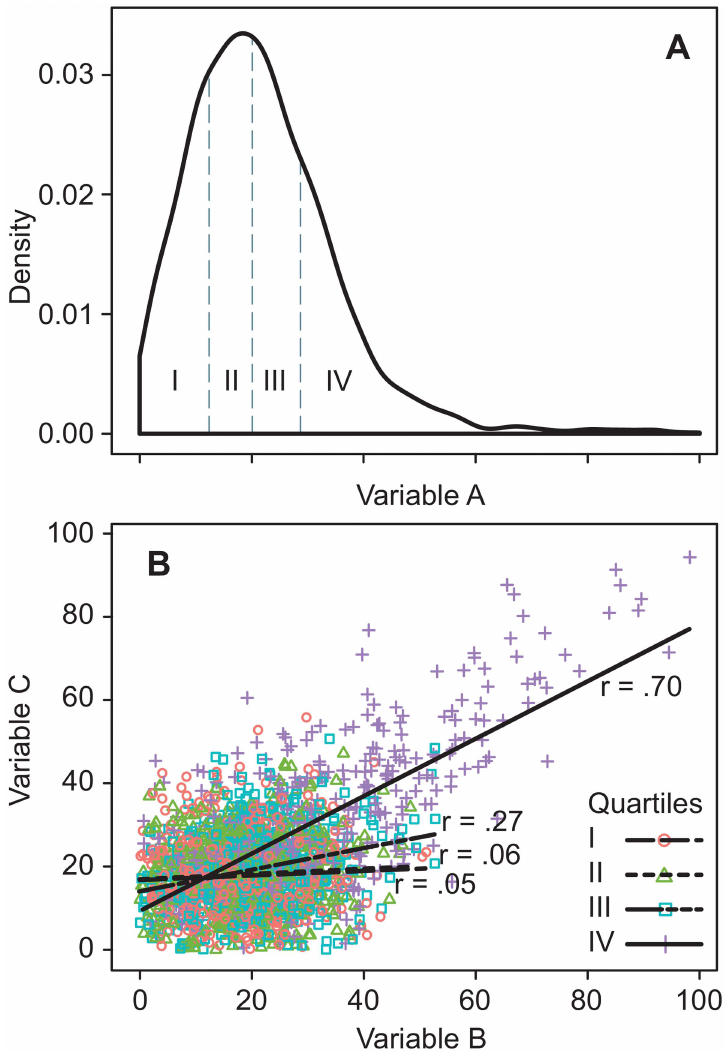
Fig 1. Differential correlations due to different subgroup variances. (A) Density plot of a skewed variable(symptom A) partitionedinto 4 quartilegroups, demonstrating differential variancesacross the subgroups. (B) Correlationsbetween 2 skewed variables (symptoms B and C) that are correlated with symptom A and with each other. Across subgroups the correlationsvary as a function of different subgroup variances. Subgroupspecific correlationcoefficients are